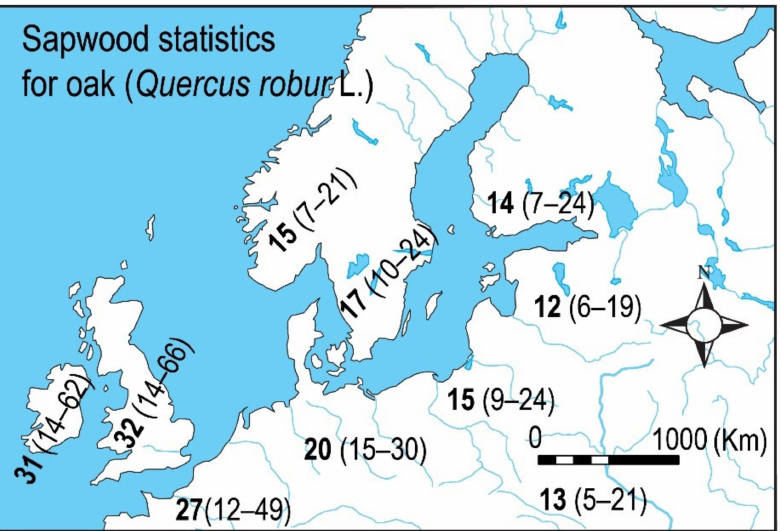
Figure 5. Map showing the geographical distribution of the estimated number of sapwood rings in oaks growing in Northern Europe: Sweden [79], Norway [80], Finland [3], Ireland [81], Northern France [82], Northern Germany [83], England [84], Northern Poland [85] Czech Republic [3], and Eastern Baltic [86]. In bold is the average number of sapwood rings for 100–200 years old oak trees in the geographic region and in brackets the range (min–max) of sapwood